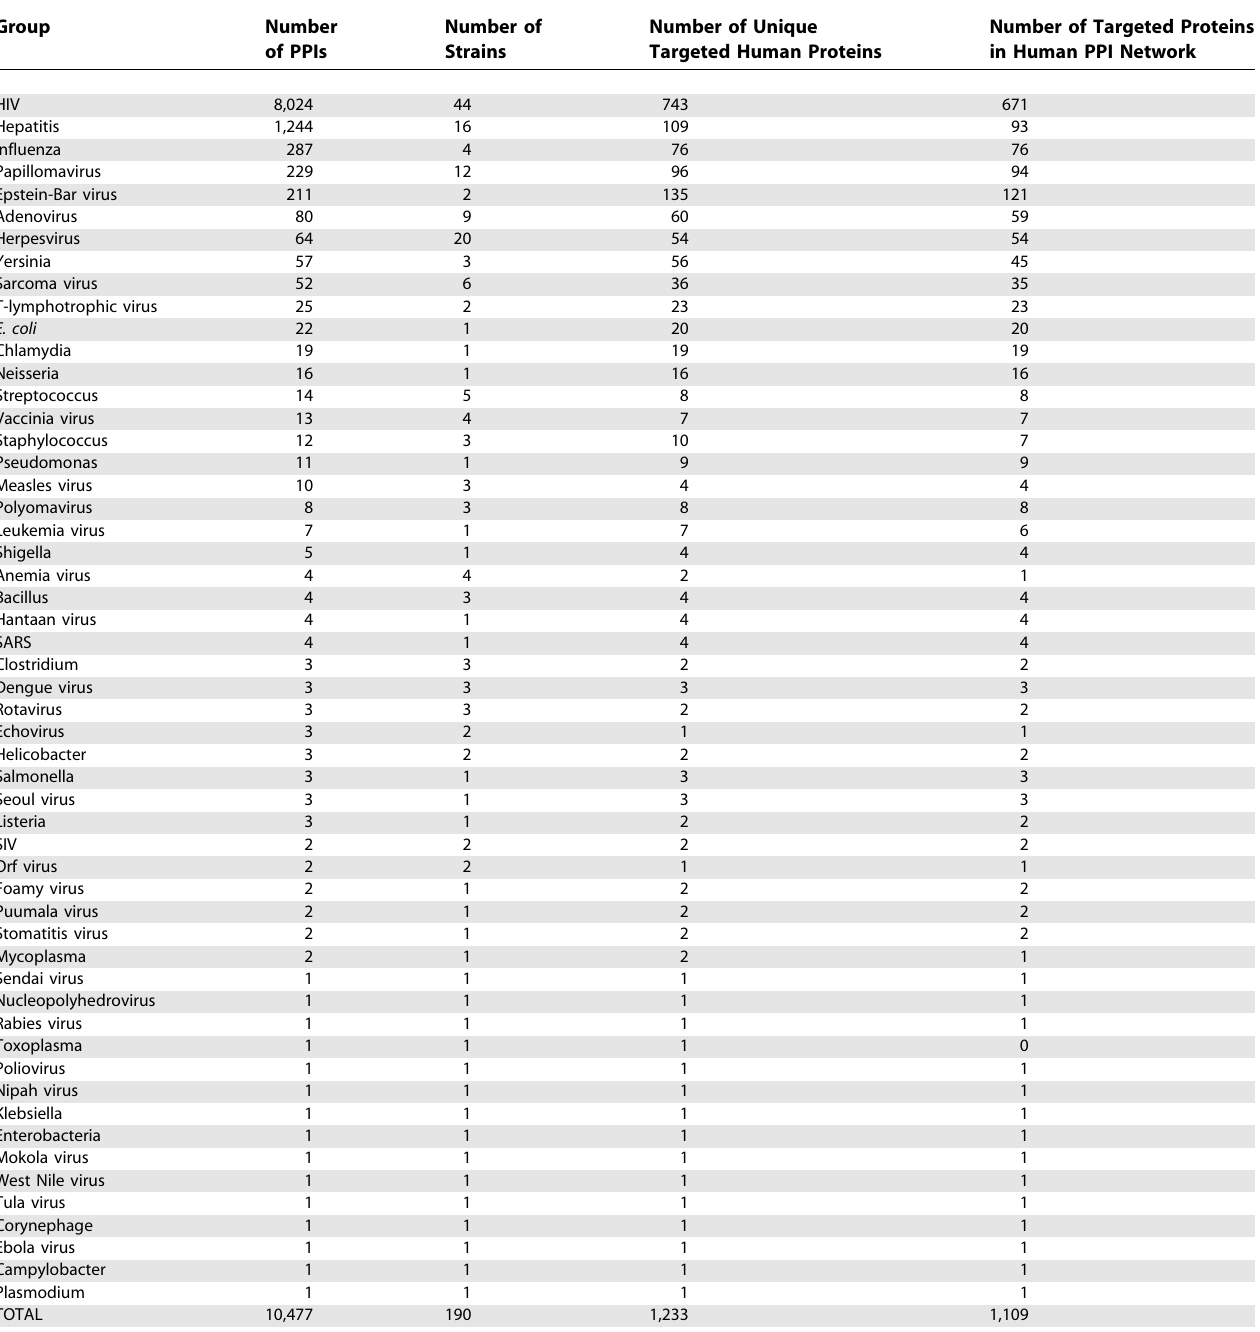
Table 3. Interaction Summary Group Number